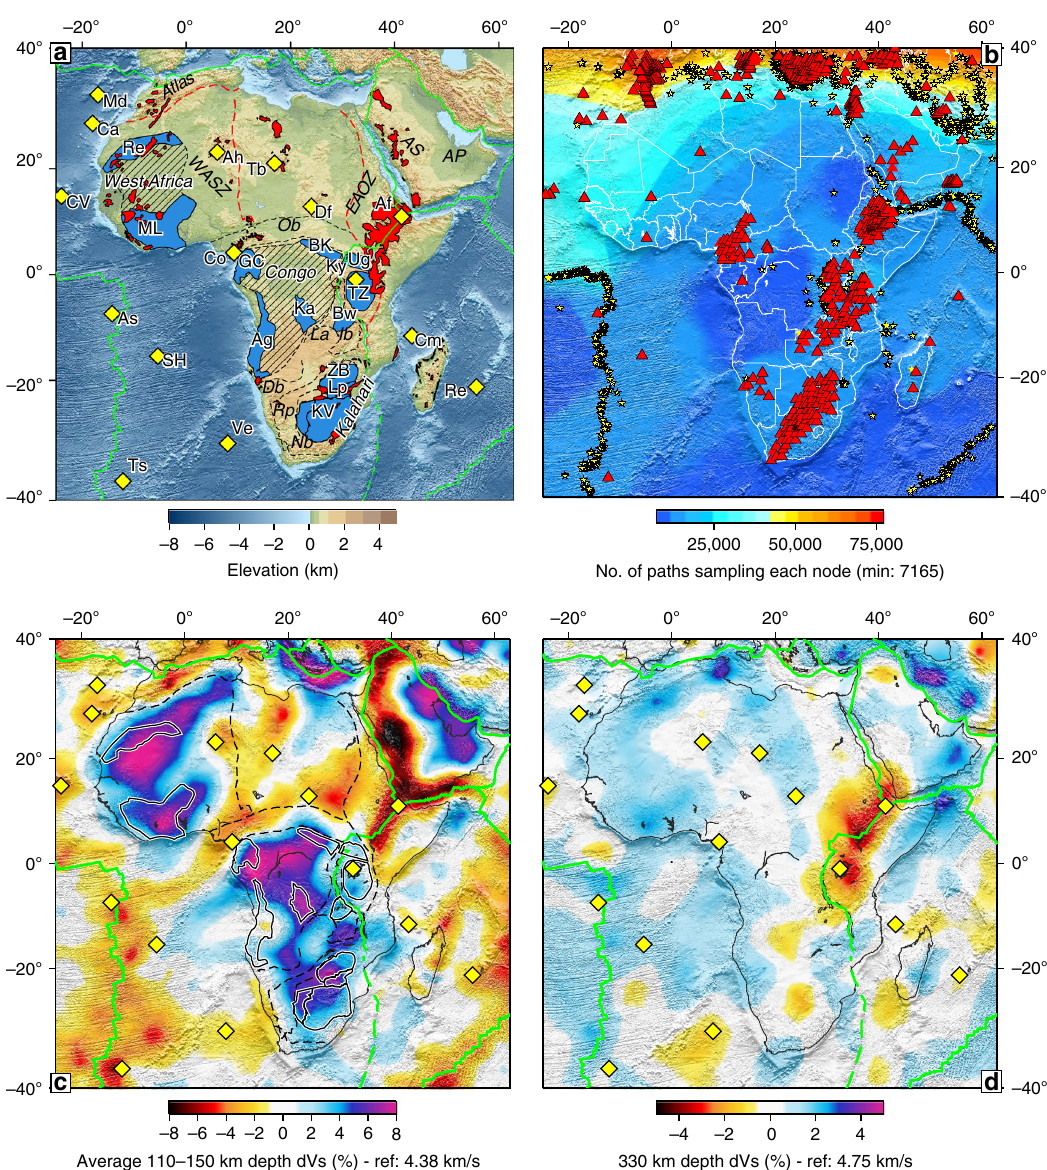
Fig. 1 Main tectonic features, seismic data coverage and our tomography of Africa. a Cratons and other primary features. Archean shields are plotted in blue: Re Reguibat, ML Man-Lèo, GC Gabon-Cameroon, BK Bomu-Kibali, Ug Uganda, TZ Tanzania, Ka Kasai, AG Angola, Bw Bangweulu Block, ZB Zimbabwe, Lp Limpopo Block, KV Kaapvaal. Mobile belts are plotted in black dashed lines: Ob Oubanguides, Ib Irumide, Db Damara, Nb Namaqua, La Lu fi lian Arc, Rp Rehoboth Province. Large Igneous Provinces and Volcanics are plotted in red, hotspots as yellow diamonds: Md Madeira, Ca Canary, As Ascension, SH Saint Helena, Ve Vema, Ts Tristan da Cunha, Cm Comoro, Re Reuniòn, Ah Ahaggar, Tb Tibesti, Df Darfur, Af Afar, Ky Kenyan. Other features: WASZ West African Shear Zone, EAOZ East African Orogenic Zone, AS Arabian Shield, AP Arabian Platform, Atlas Atlas Mountains. b seismic stations (red triangles) and events (yellow stars) used in tomography, plotted on the hit-count map of data sampling. c Average shear-wave speed ( V S ) in the 110 – 150 km depth range, with geological features as in a . d V S at 330 km